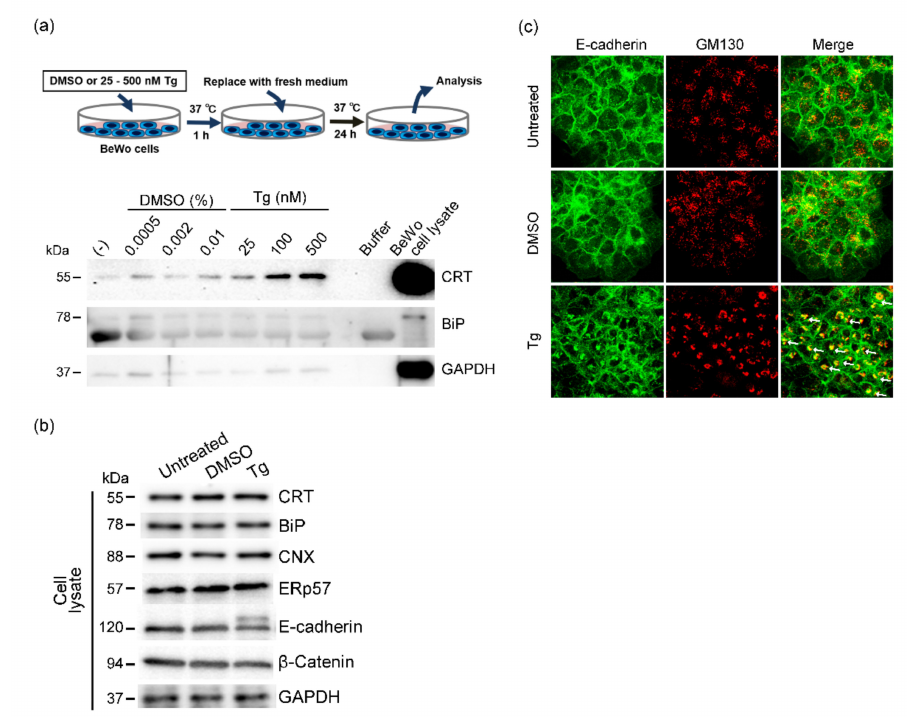
Figure 3. Extracellular release of CRT after thapsigargin-induced ER stress in BeWo cells. ( a ) BeWo cells were treated with thapsigargin (Tg) or DMSO for 1 h at 37 ◦ C. After samples were washed three times with PBS, culture media were replaced with fresh Opti-MEM and cells were cultured for 24 h at 37 ◦ C. Conditioned medium samples were then collected and CRT protein levels were analyzed by means of Western blotting. GAPDH and BiP served as markers for the cytosol and the ER, respectively. ( b ) Expression of ER-resident proteins in thapsigargin-treated (Tg, 100 nM) BeWo cells was analyzed by using Western blotting. GAPDH served as the loading control. ( c ) DMSO- or thapsigargin-treated (Tg, 100 nM) BeWo cells were stained with anti-E-cadherin and anti-GM130 antibodies. Arrows point to condensed E-cadherin signals that colocalized with